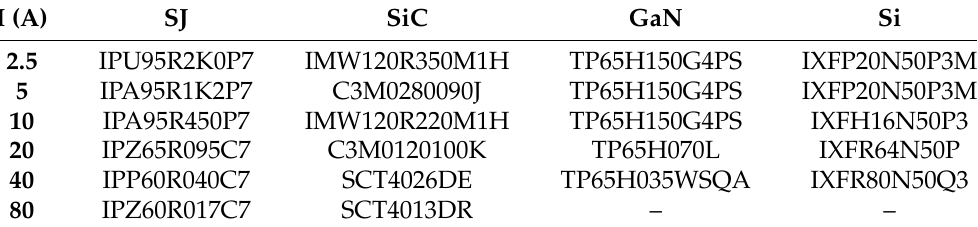
Table 2. Part numbers that were selected by the algorithm in order to minimize switching